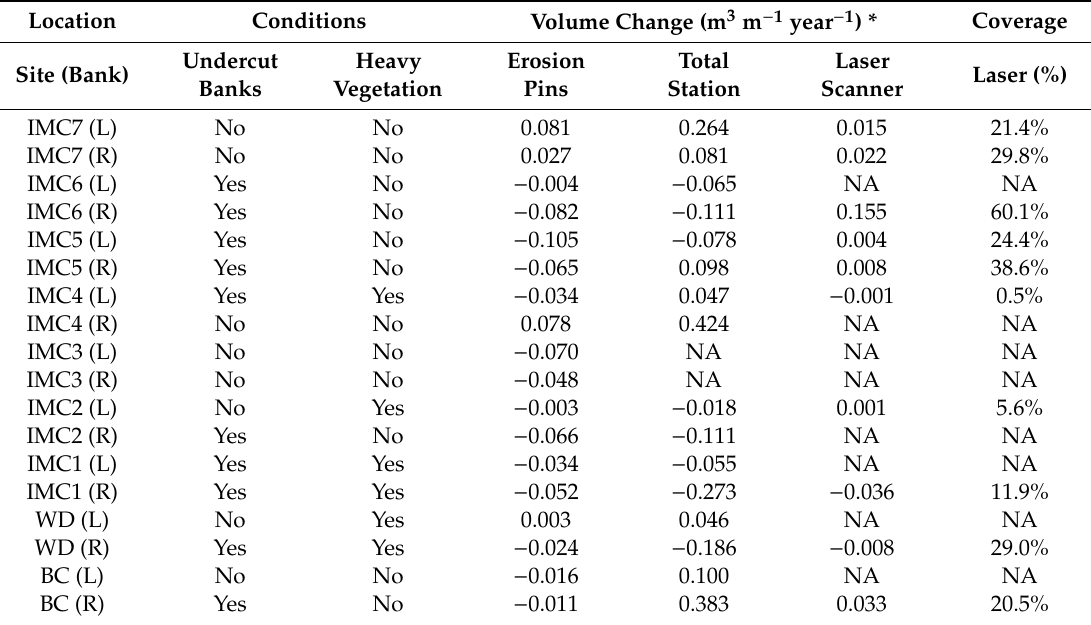
Table 1. Site conditions, volumetric results, and laser scan coverage for study streambank in the Indian Mill Creek